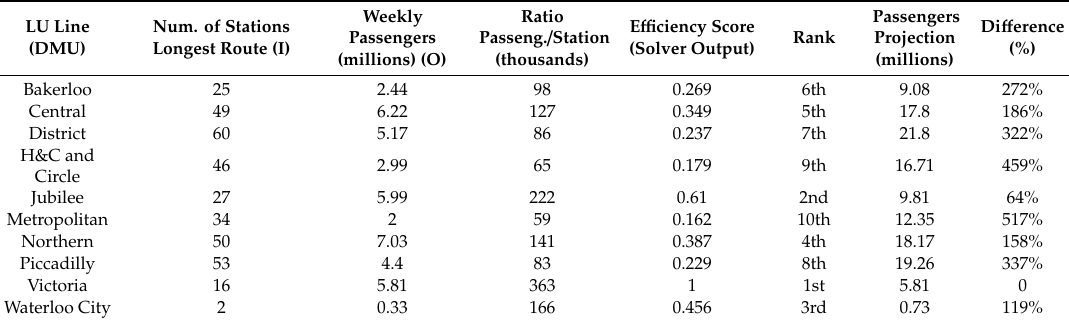
Table 1. Results of simplified URT lines DEA model of LU lines.